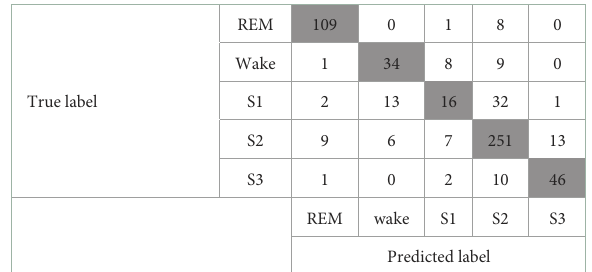
TABLE 5 Confusion matrix of one model that includes only the activity count-derived